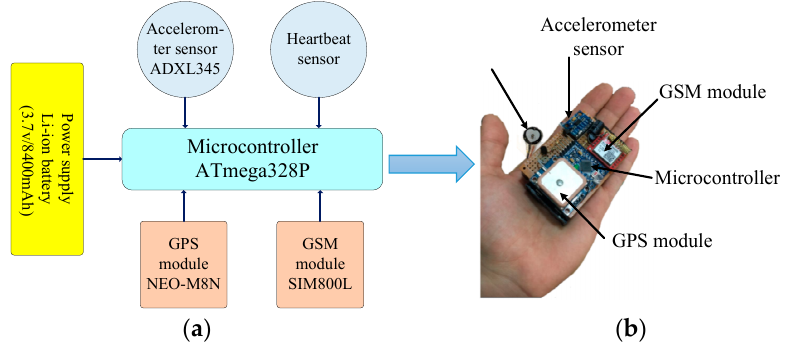
Figure 2. Proposed FDD ( a ) Block diagram, and ( b ) Hardware.